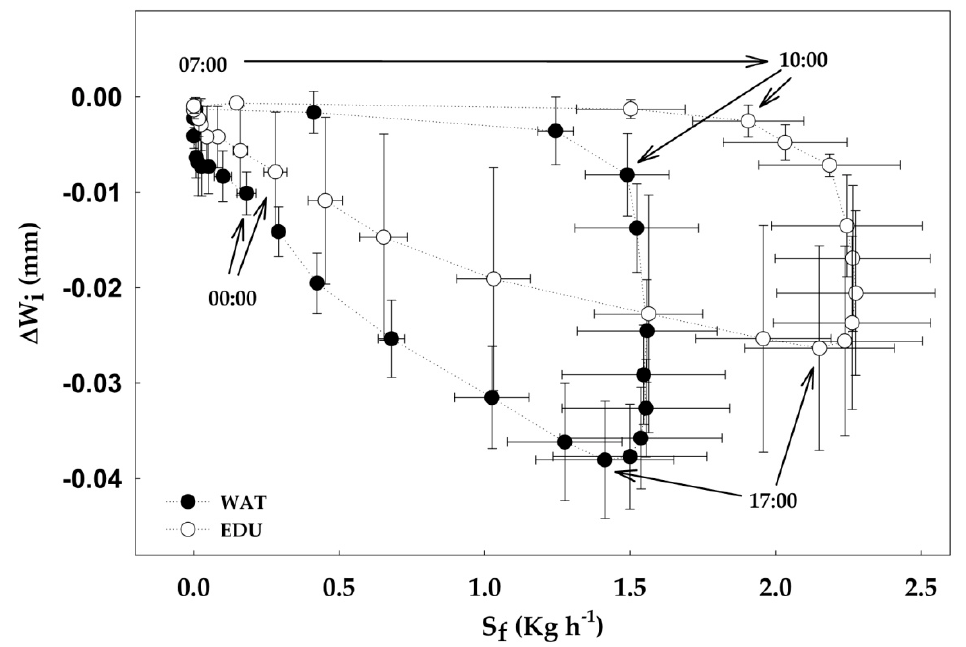
Figure 7. Daily course of changes in Δ W i , stem water deficit, (±SD) and S f , sap flow, (±SD) in WAT (water treated) and EDU (EDU treated) trees, from DOY 214 to DOY 224 ( N = 5 trees). Arrows indicates the hour of the day (00:00, 07:00, 10:00, 17:00). From 07:00 to 10:00, morning phase (MP); from 11:00 to 17:00, midday-early afternoon phase (MEP); from 18:00 to 06:00, recovery phase (RP).